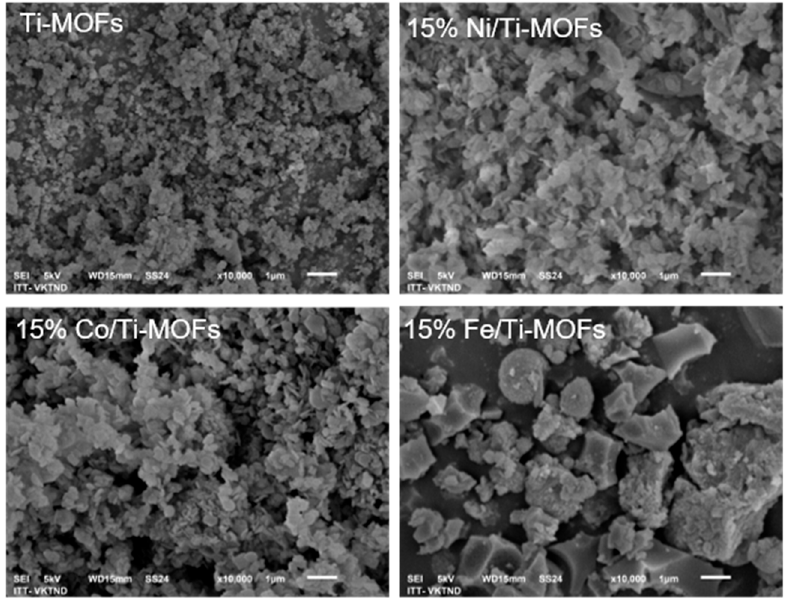
Figure 3. SEM image of NH 2 -MIL-125(Ti) and 15% M/Ti-MOFs (M: Ni, Co,